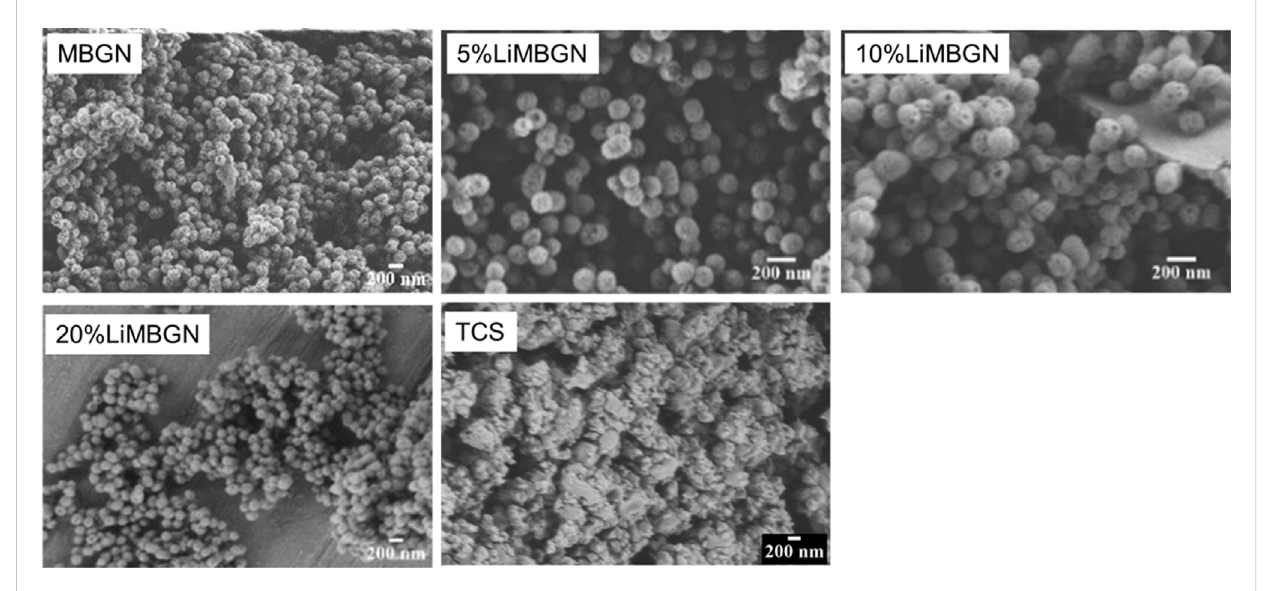
FIGURE 1 SEM images of freshly synthesized MBGNs and TCS prior to immersion.